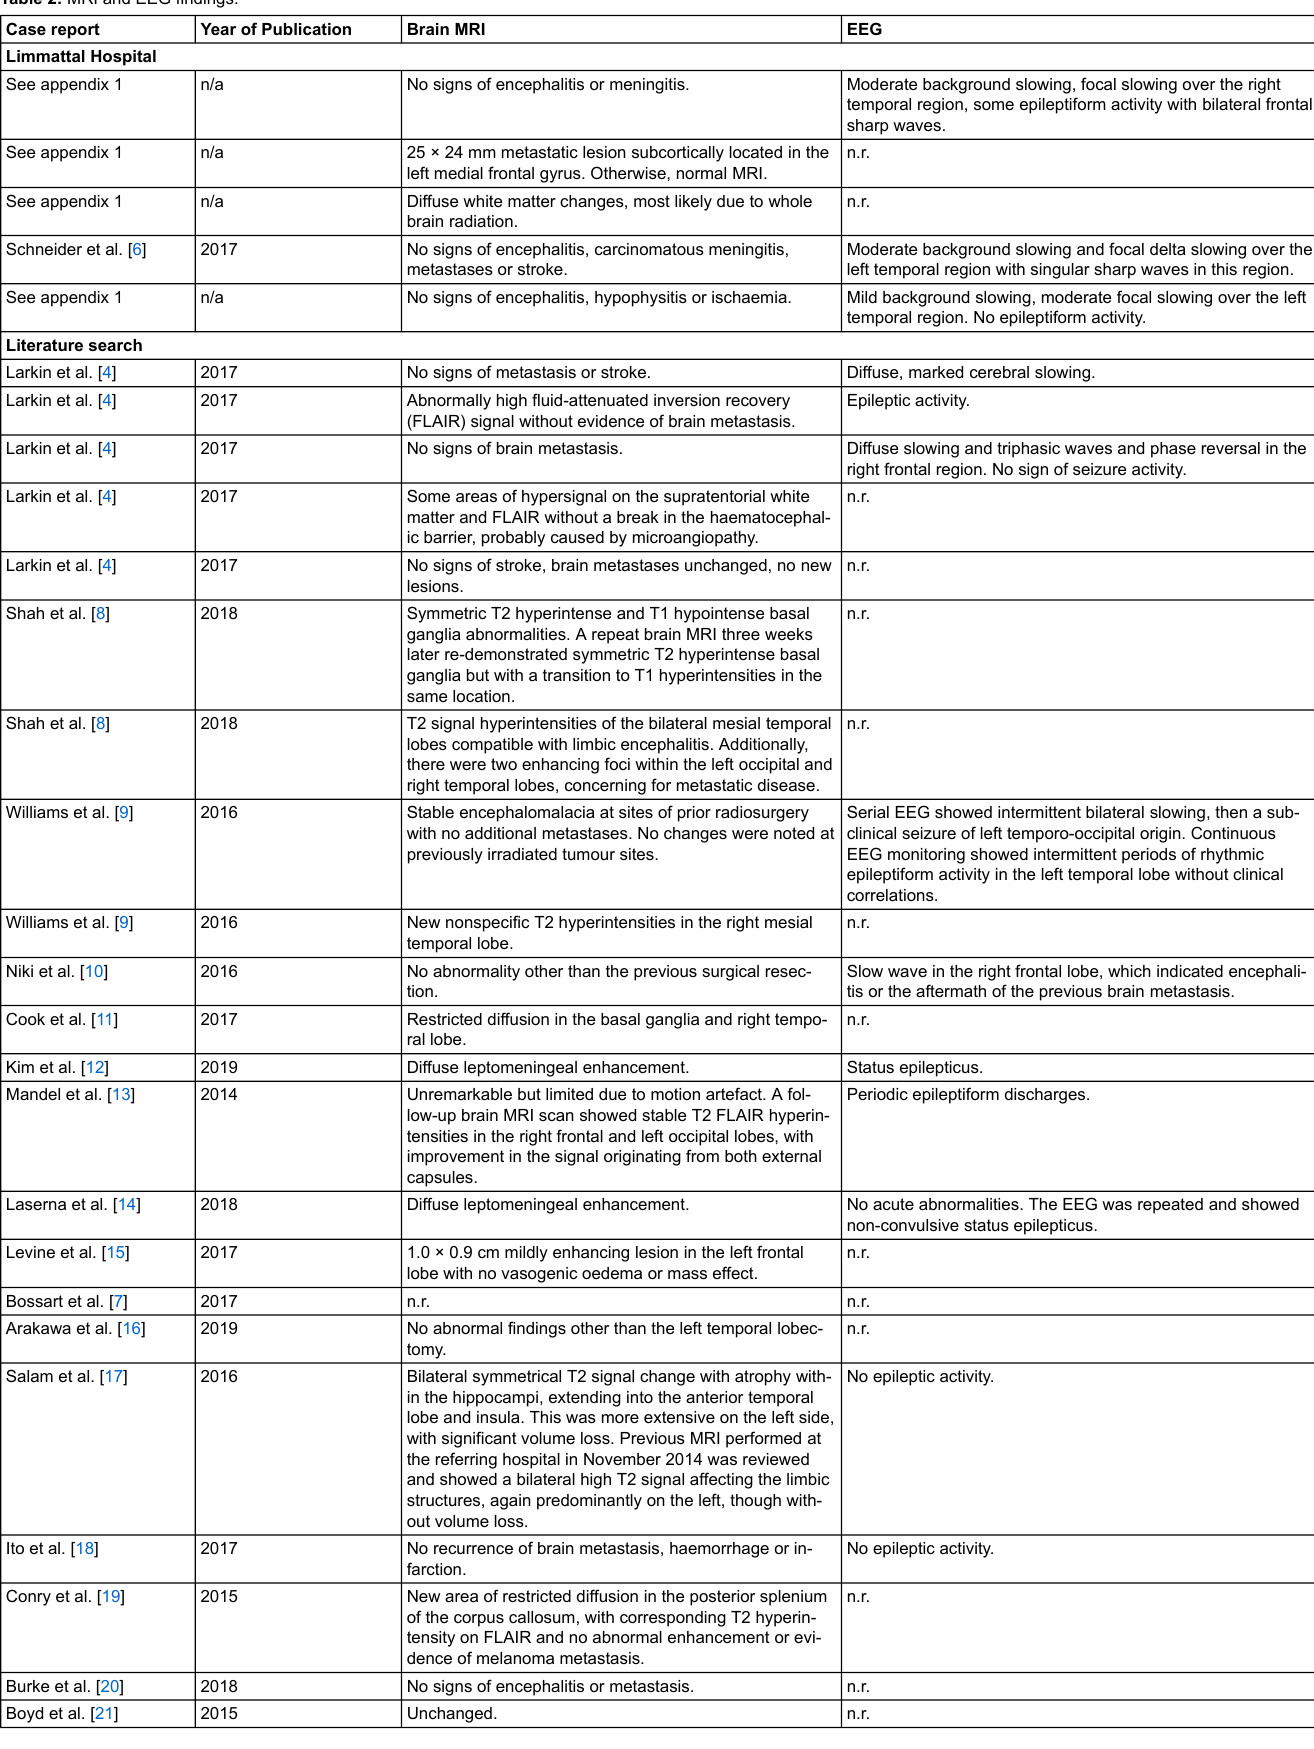
Table 2: MRI and EEG